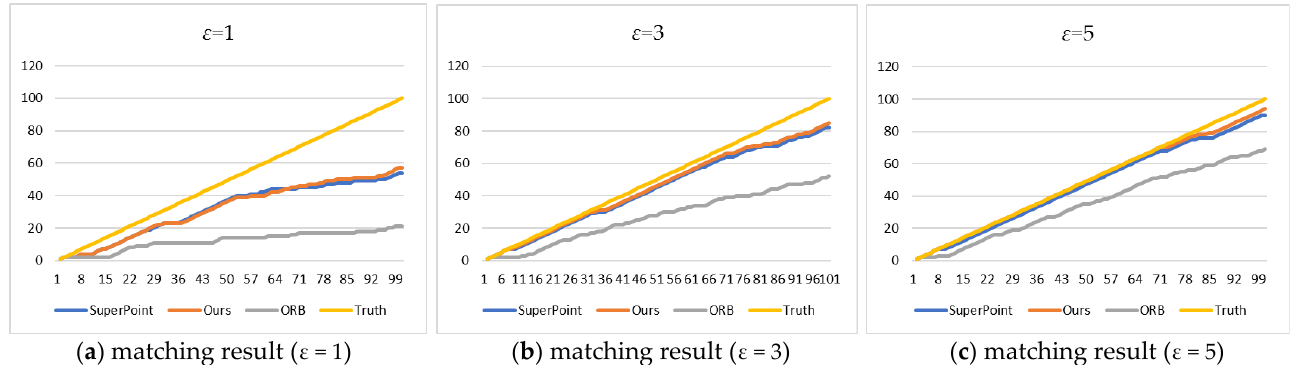
Figure 9. Successful matching performance comparison on HPatches dataset.